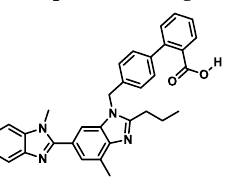
δ 12.71 (s, 2H), 6.26 (s, 2H). 6 )